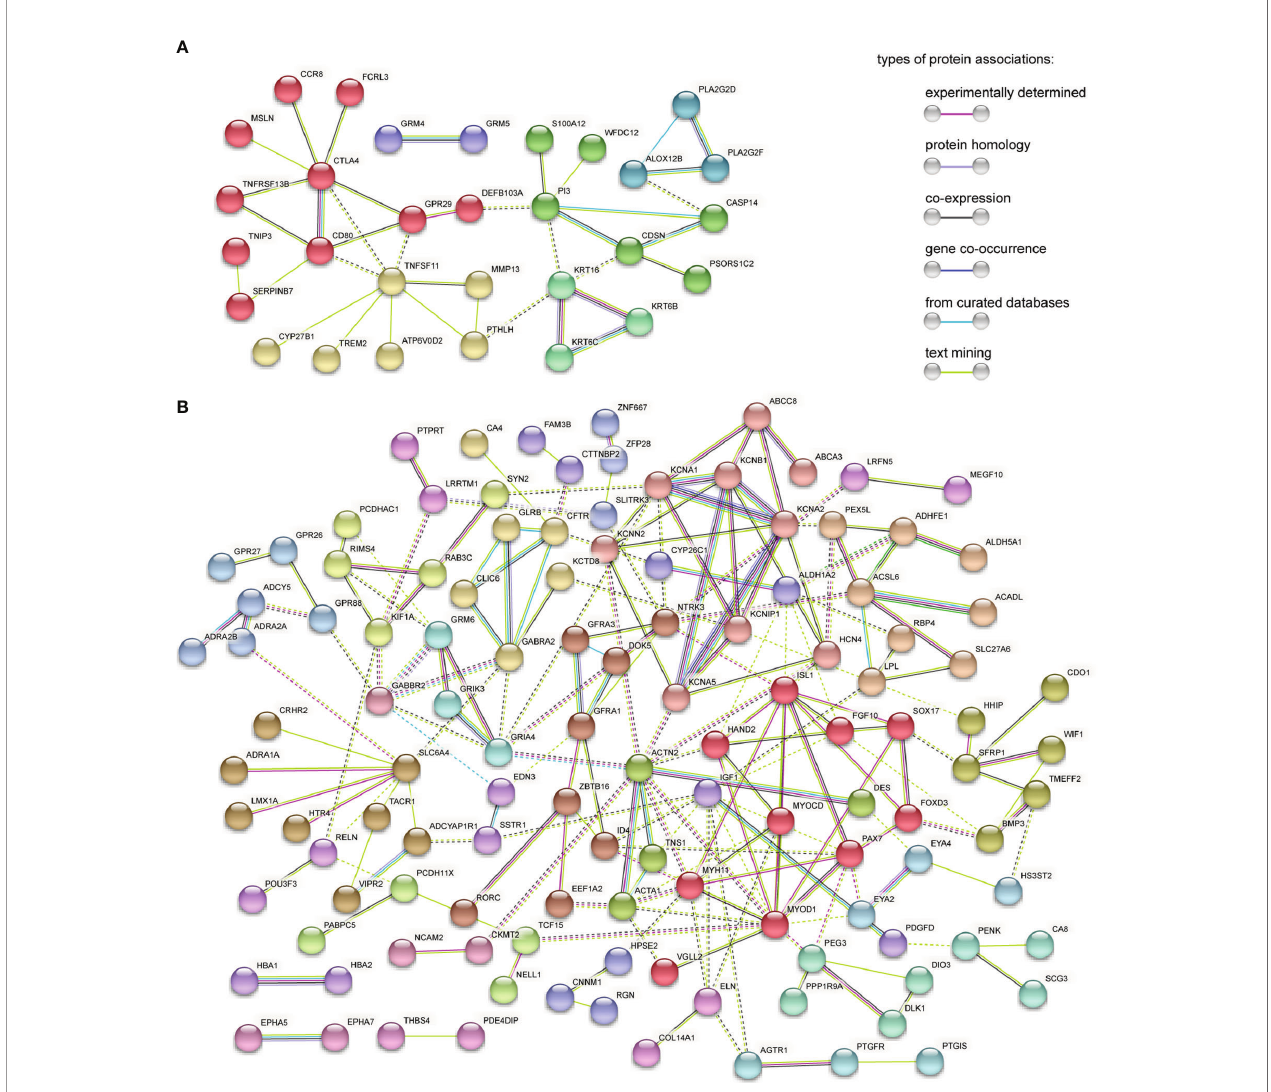
FIGURE 3 | PPI network analysis of MeDEGs. (A) PPI network of upregulated and hypomethylated genes. (B) PPI network of downregulated and hypermethylated genes. Each node represents a protein coded by unique genes, edges indicate interactions, and the color of edge indicates the degree of associations between proteins. Disconnected nodes in the network were hidden. Protein networks are clustered on MCL in fl ation parameter 2. Nodes from the same cluster are presented in the same color. Edges between different clusters are represented by dashed